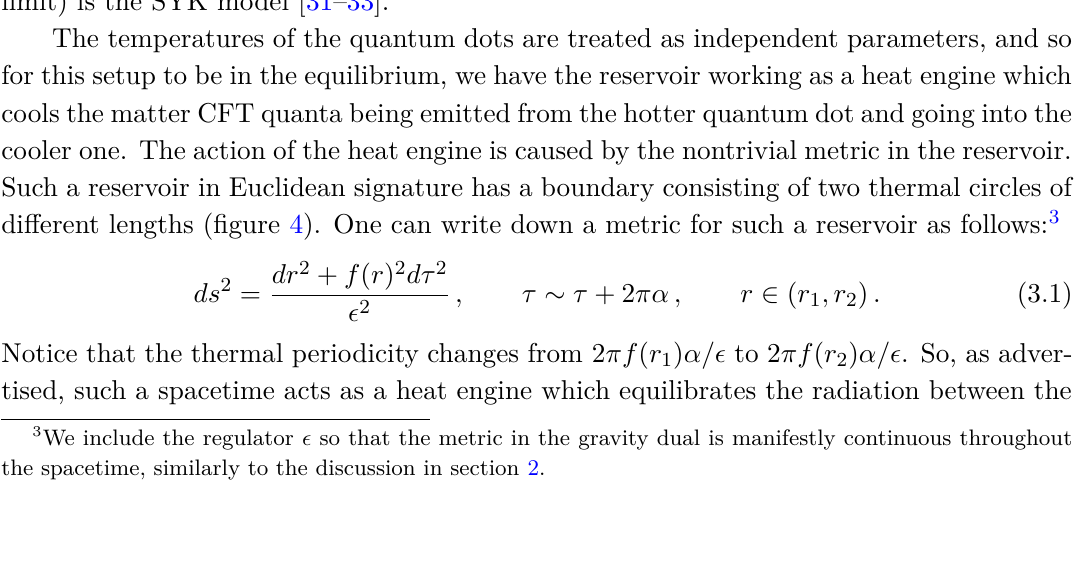
Figure 3. A . The entanglement entropy curves for the configurations (a), (b), (c) and (d) for region size much larger than the distance from the interface and comparable to φ curve of a finite segment, obtained by minimizing between the saddles shown in plot